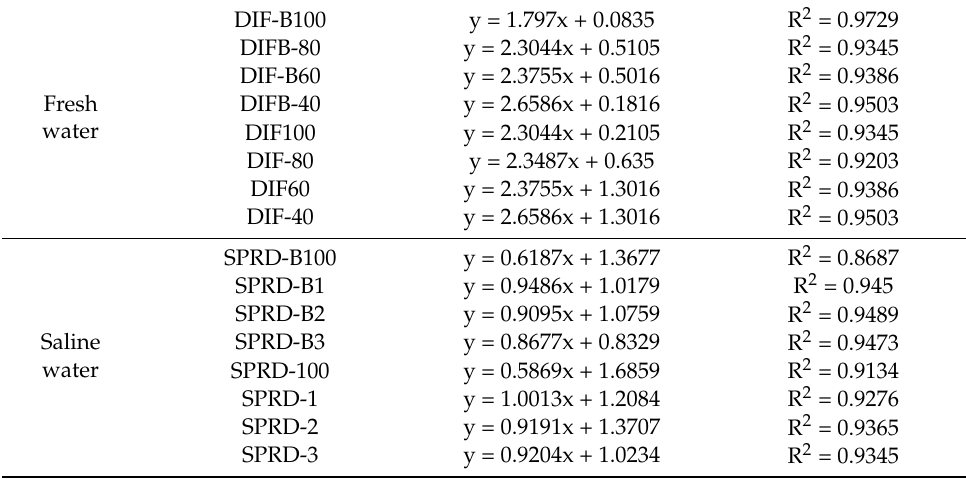
Table A1. Equations of infiltration obtained by plotting infiltration rate versus 1/(2 t 0.5) and fitting a linear